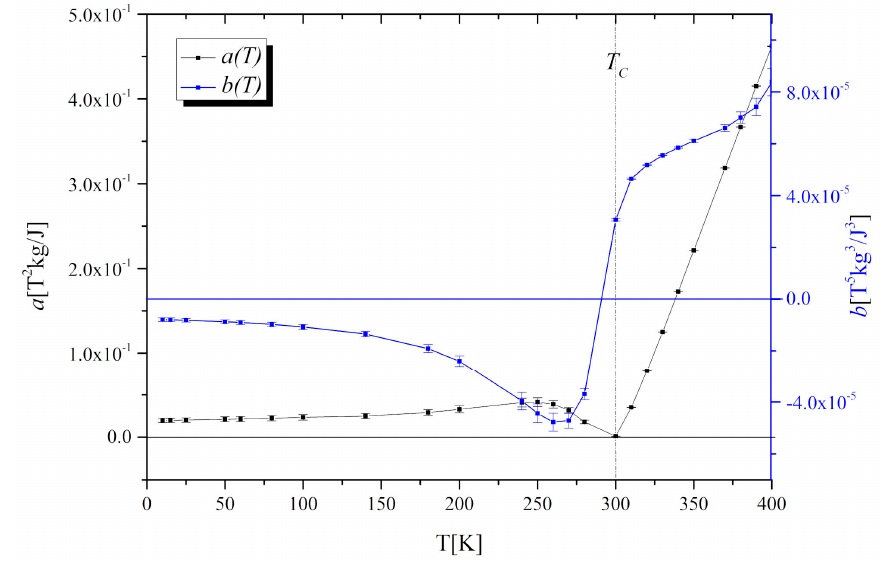
Figure 6. The temperature dependence of Landau coefficients a(T) and b(T) for the Gd 0.4 Tb 0.6 Co 2 .